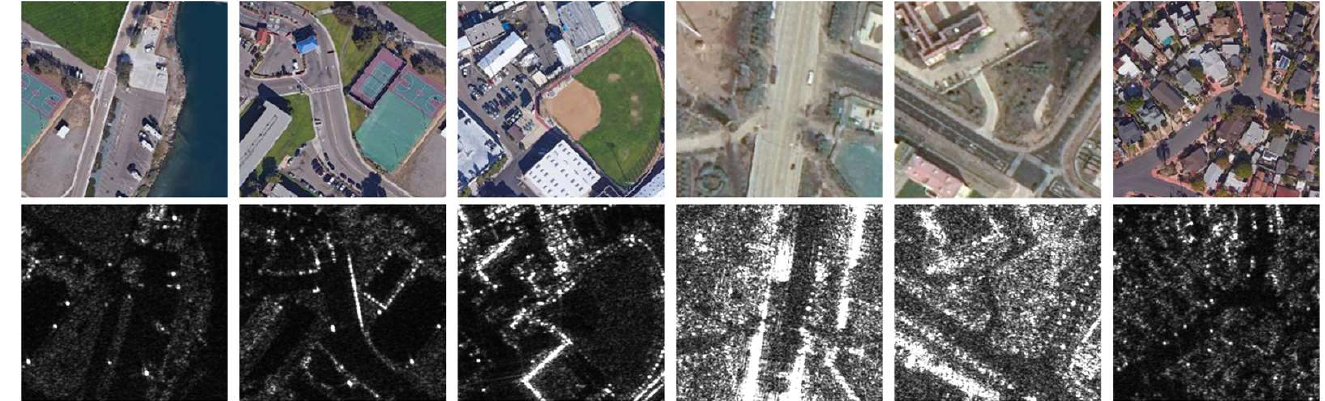
Figure 4. Sample image pairs of two-channel matching network training data.